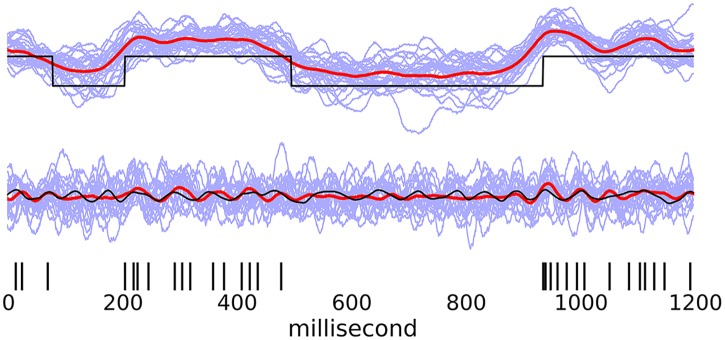
Spike train modulated with fast oscillation and a slower square-wave fluctuation.For a sample trial, top shows inferred, square-wave modulation of spiking (black) and the inferred latent state (red). Bottom shows inference of faster rhythm by taking the slow signal shown above to be a known signal, and re-running LOST.